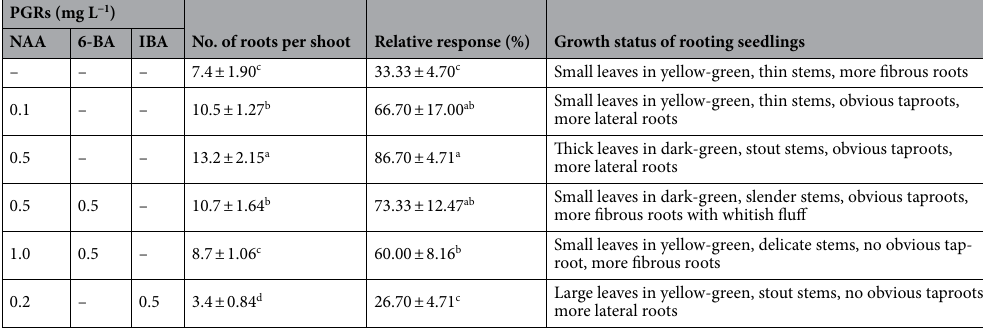
Table 4. Effect of PGRs and their concentrations on roots formation frequency and number of roots. The data represented mean ± standard error; Different letters within different root induction mediums indicate significant differences ( P < 0.05) comparing the treatments.